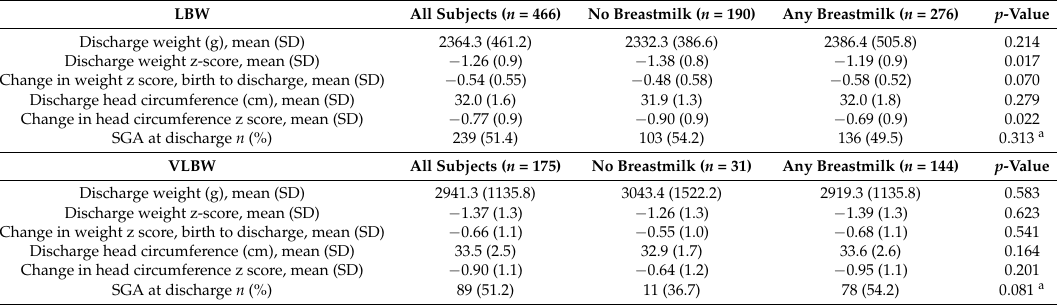
Table 3. Growth outcomes by breastmilk